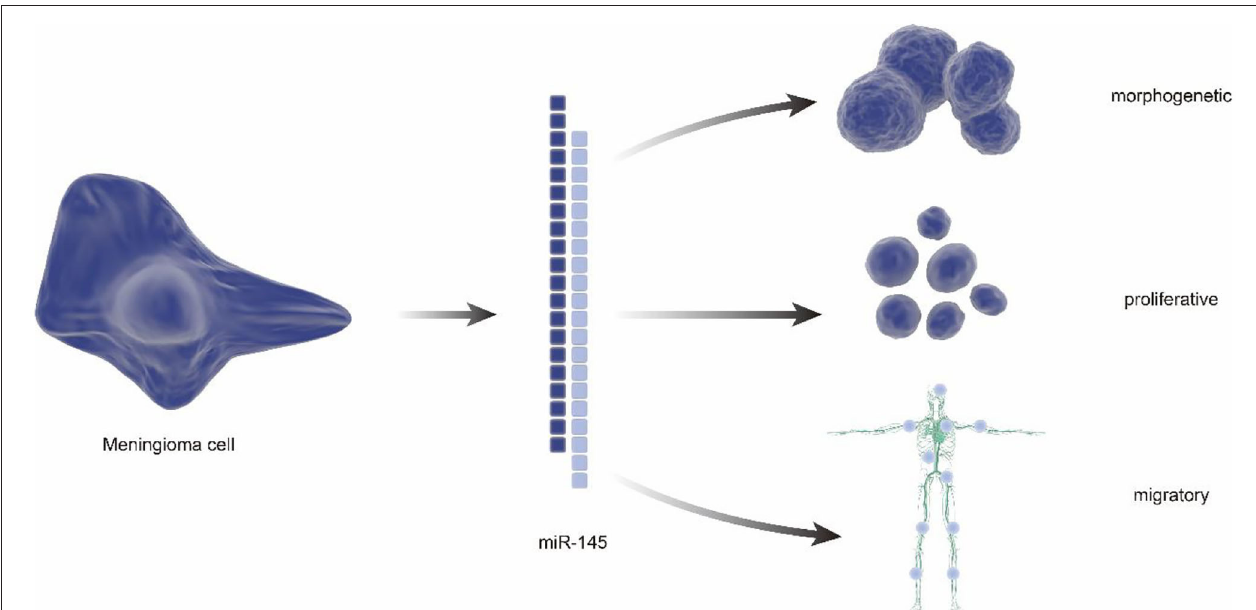
FIGURE 3 | The regulatory role of miRNA in meningiomas. miRNA has a reduced expression in atypical and anaplastic meningiomas, which increases cell proliferation and reduces apoptotic susceptibility. In addition, reduced miRNA reduces migration, invasion, and adhesion of meningioma cells. It can also alter meningioma cell morphology, resulting in low elongation and